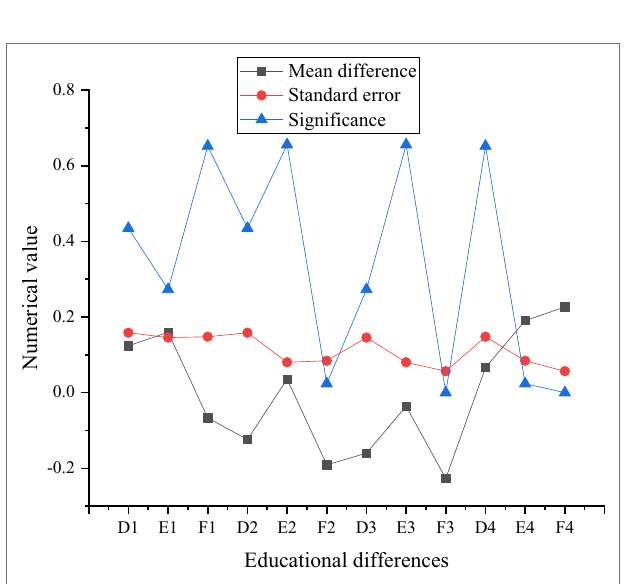
FIGURE 11 | Multiple comparison results of psychological capital under educational differences (D1, E1, and F1 are high school and below, D2, E2, and F2 are college degrees, D3, E3, and F3 are undergraduate degrees, and D4, E4, and F4 are master’s and above).